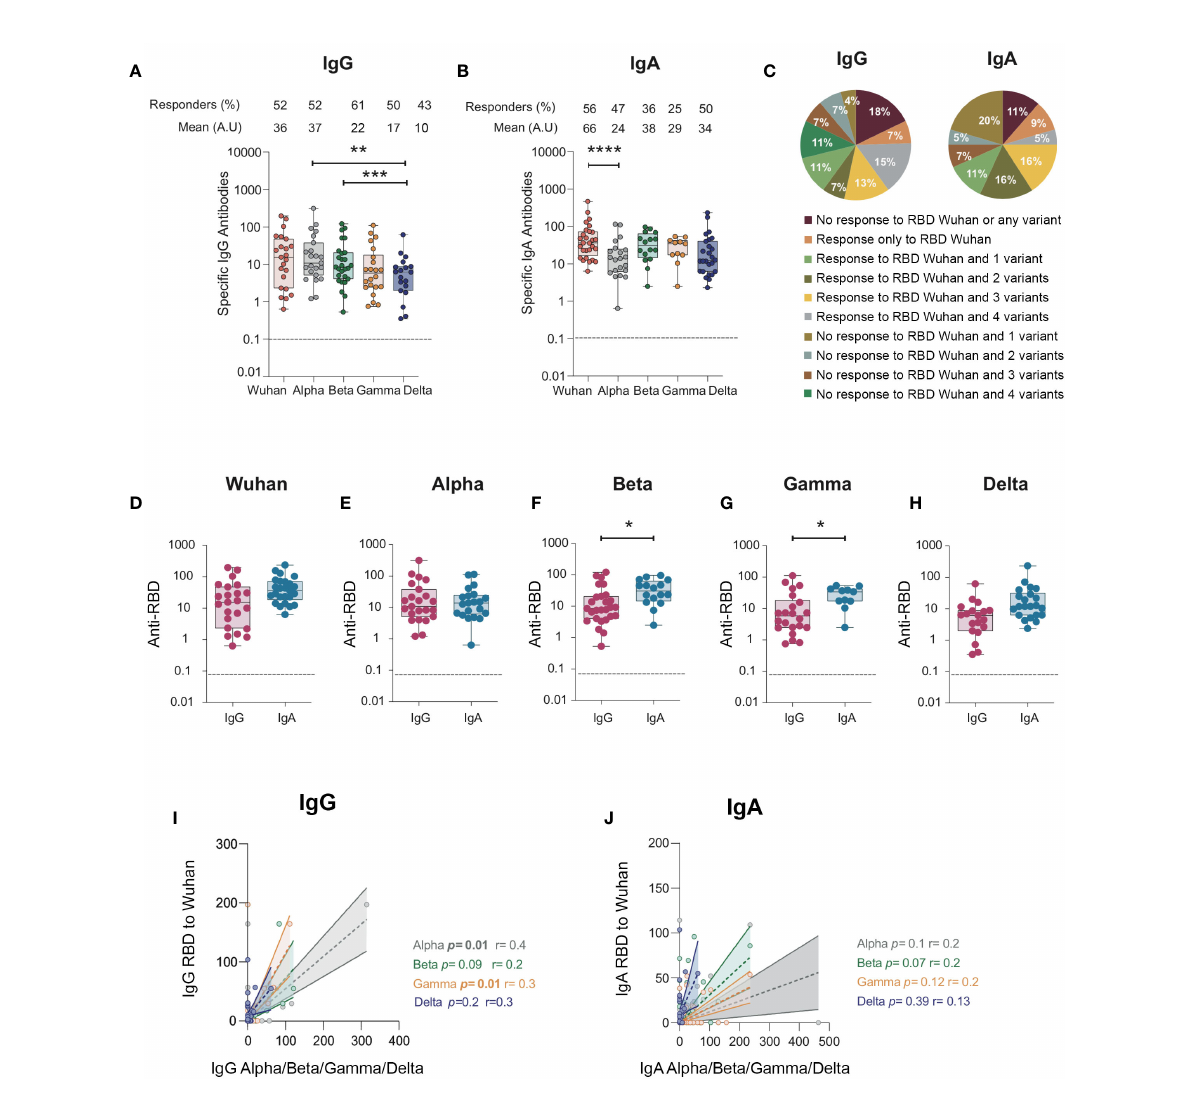
FIGURE 4 IgG and IgA antibodies from BAL from SARS-CoV-2-infected individuals against RBD protein from SARS-CoV-2 Alpha (B.1.1.7), Beta (B.1.351), Gamma (P.1), and Delta (B.1.617) variants. (A) Speci fi c IgG responses against Alpha, Beta, Gamma, and Delta RBD in BAL from SARS-CoV-2- infected individuals. (B) Speci fi c IgA responses against Alpha, Beta, Gamma, and Delta RBD in BAL from SARS-CoV-2-infected individuals. (A, B) Proportion of speci fi c IgG or IgA over total IgG or IgA measured by ELISA (speci fi c (OD450)/total IgA or G ( m g/ml)) are shown. (C) Pie charts showing the percentages of the different responses of IgG (left) and IgA (right) to Wuhan RBD and the different variants. (D – H) Comparison between speci fi c IgG and IgA responses detected against the RBD from ancestral Wuhan strain (D) , Alpha (E) , Beta (F) , and Gamma (G) and Delta (H) variants. Correlation between IgG (I) and IgA (J) speci fi c to Wuhan RBD and IgG and IgA antibodies speci fi c for Alpha, Beta and Gamma variants. Correlations were calculated using Spearman ’ s test. p -Values were calculated by using Wilcoxon test. *, p < 0.05; **, p < 0.01; ***, p < 0.005, ****, p < 0.0001. Dashed line: cutoff value for antibody detection. BAL, bronchoalveolar lavage; RBD, receptor-binding